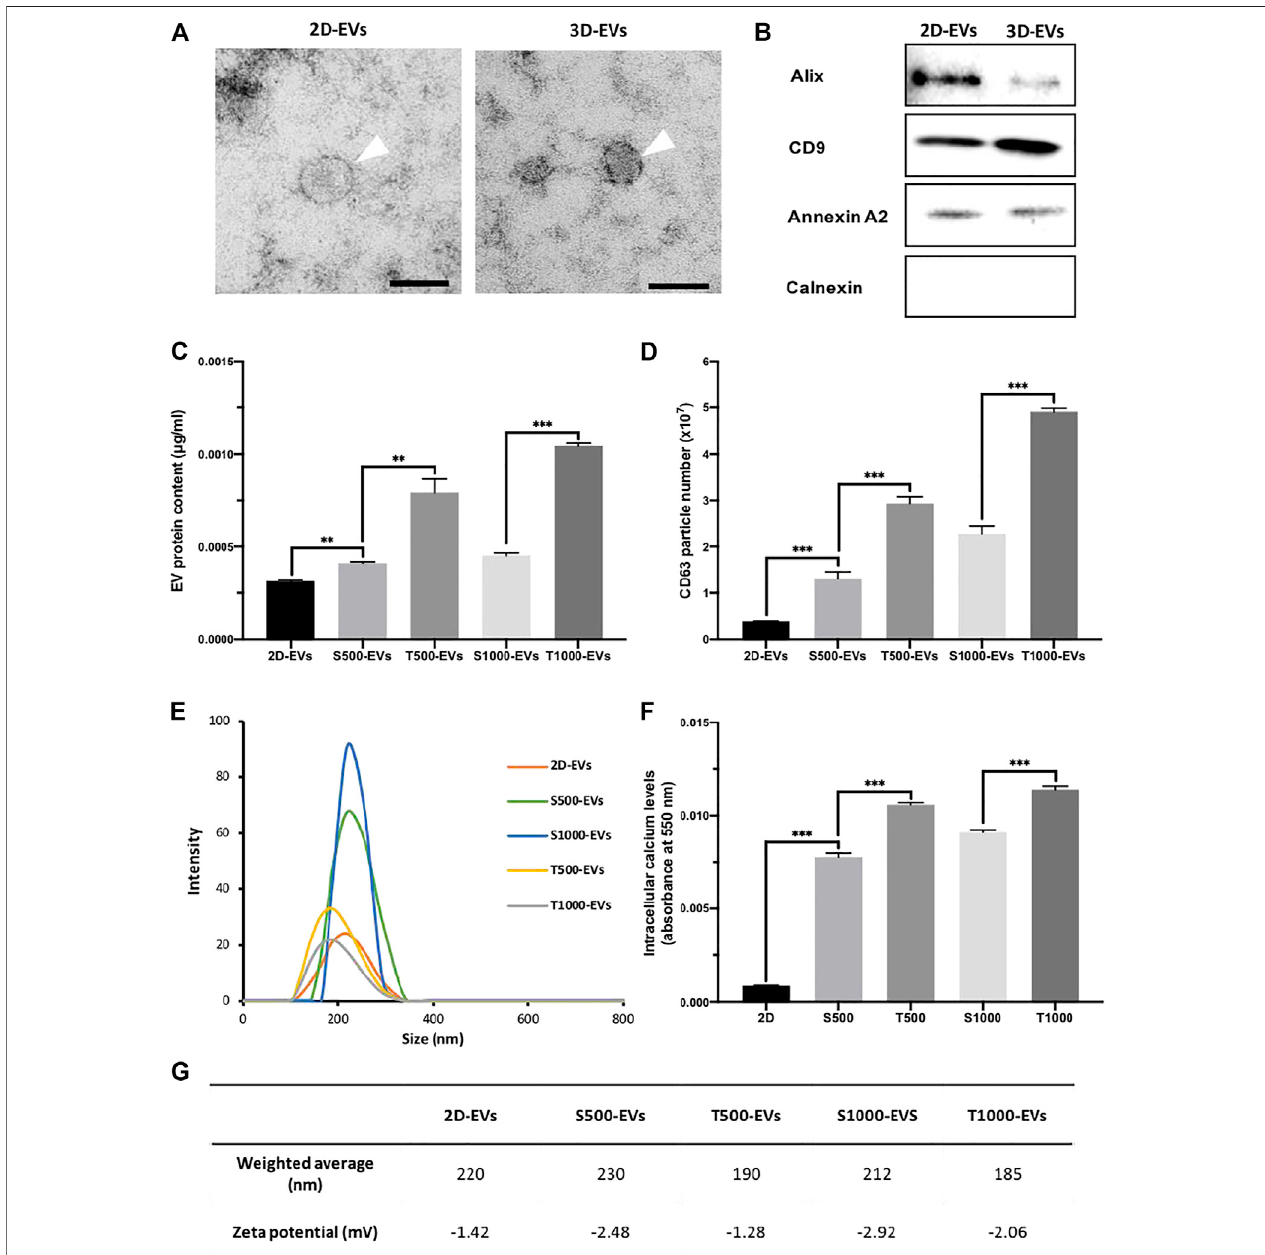
FIGURE 4 | Characterisation of osteoblast-derived EVs: (A) representative TEM image ofEVs derived from 2D and 3D culture, scale bar (cid:2) 50 nm, (B) western blot analysis, (C) EV protein content, (D) CD63 + particles quanti fi cation, (E) size distribution, (F) intracellular calcium content and (G) weighted average diameter and zeta potential of isolated EVs. Data are expressed as mean ± SD (n (cid:2) 3). **P ≤ 0.01 and ***P ≤